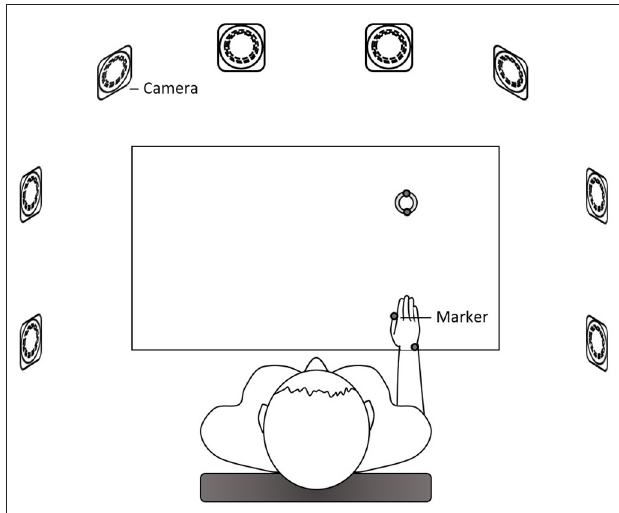
FIGURE 2 | The setup of the right-hand measurement. Eight cameras surrounded the table. Reflective markers were placed on the ulnar styloid process (representing the wrist) and the thumbnail of the right hand and on the object.